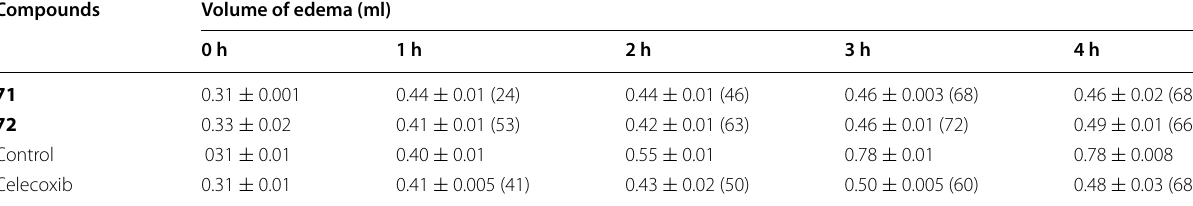
Table 22 Inflammation reduction results of synthesized compounds in Formalin induced rat paw edema bioassay Compounds